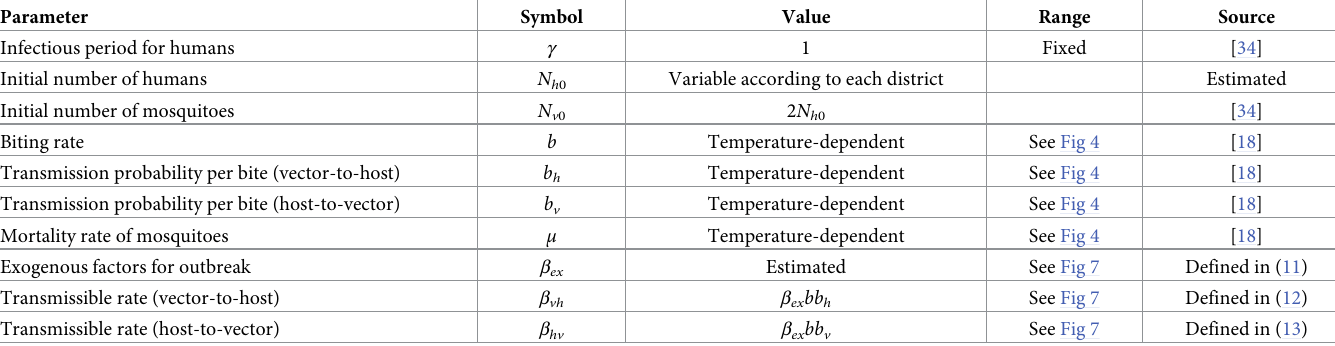
Table 1. Model parameters.